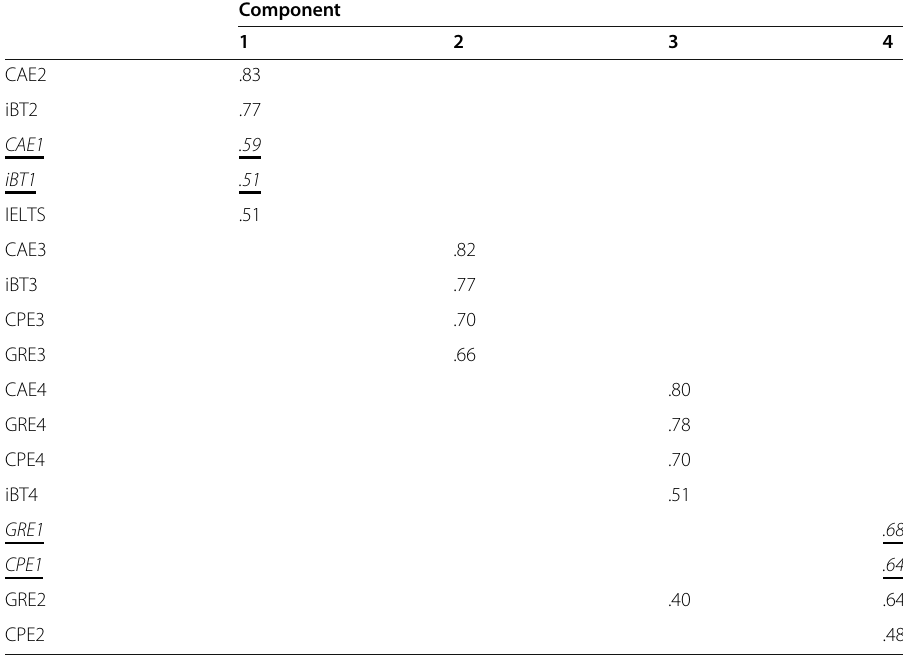
Table 7 Rotated component matrix